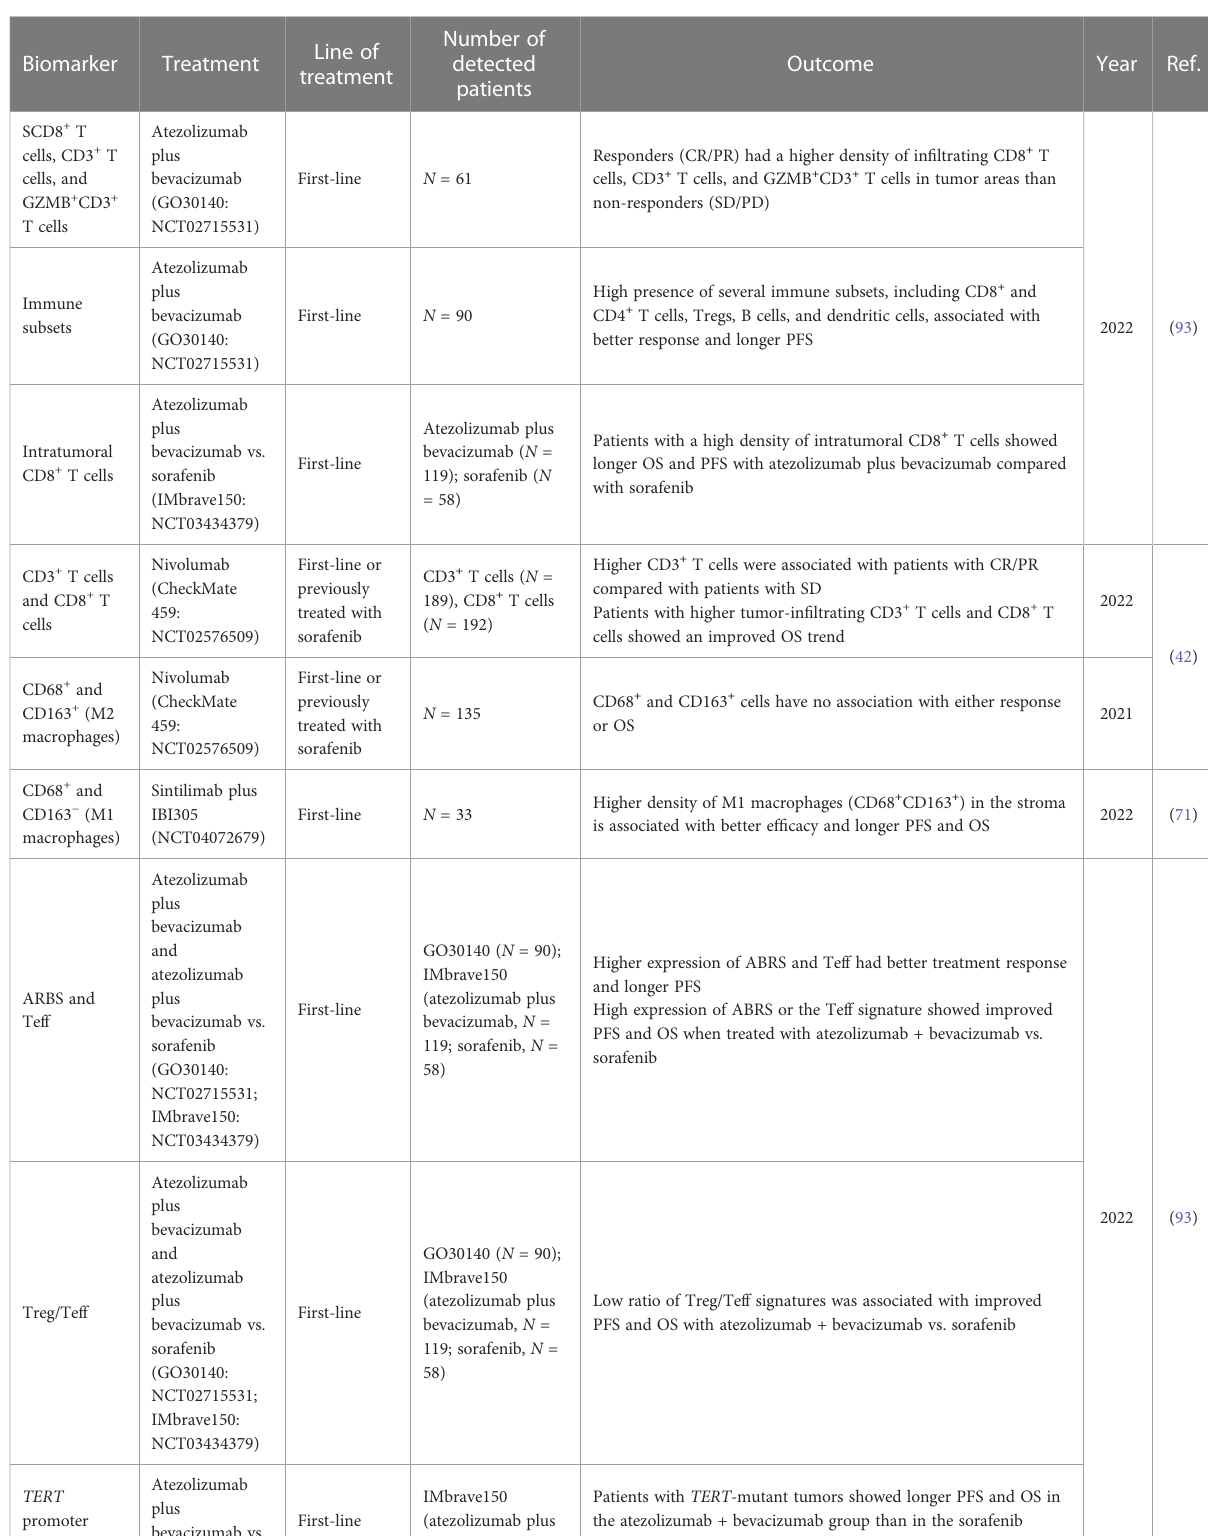
TABLE 2 Predictive or prognostic biomarkers in tumor tissues for HCC immunotherapy. Biomarker Treatment